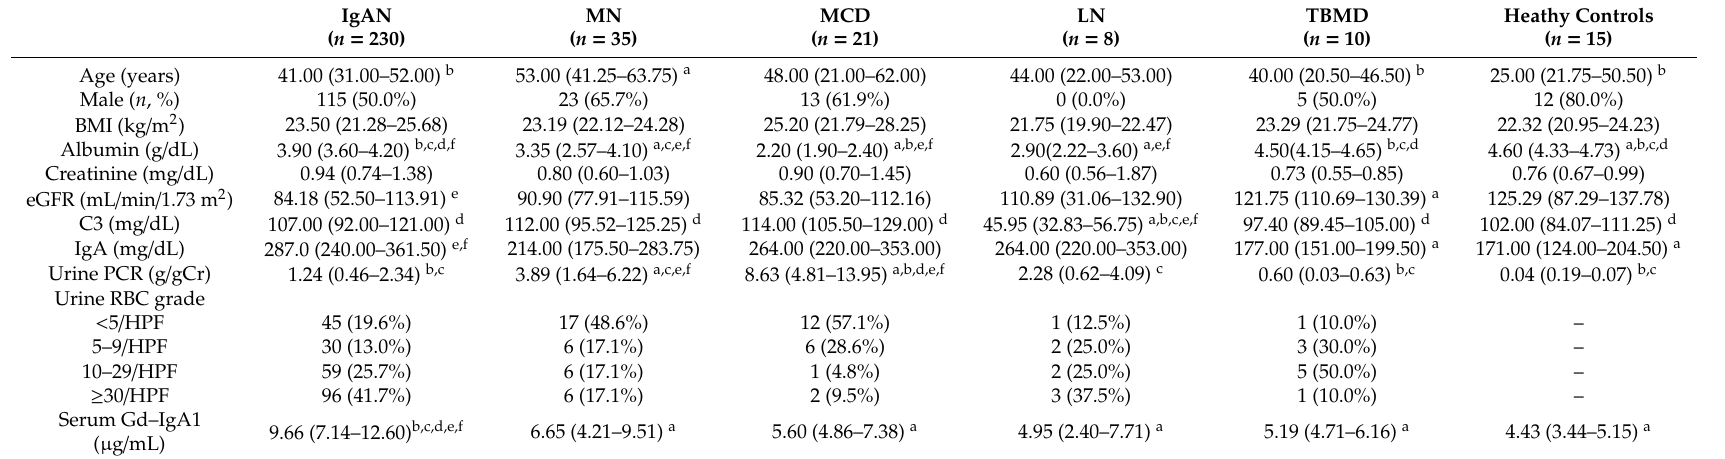
Table 1. Baseline characteristics of the study population according to the type of glomerular